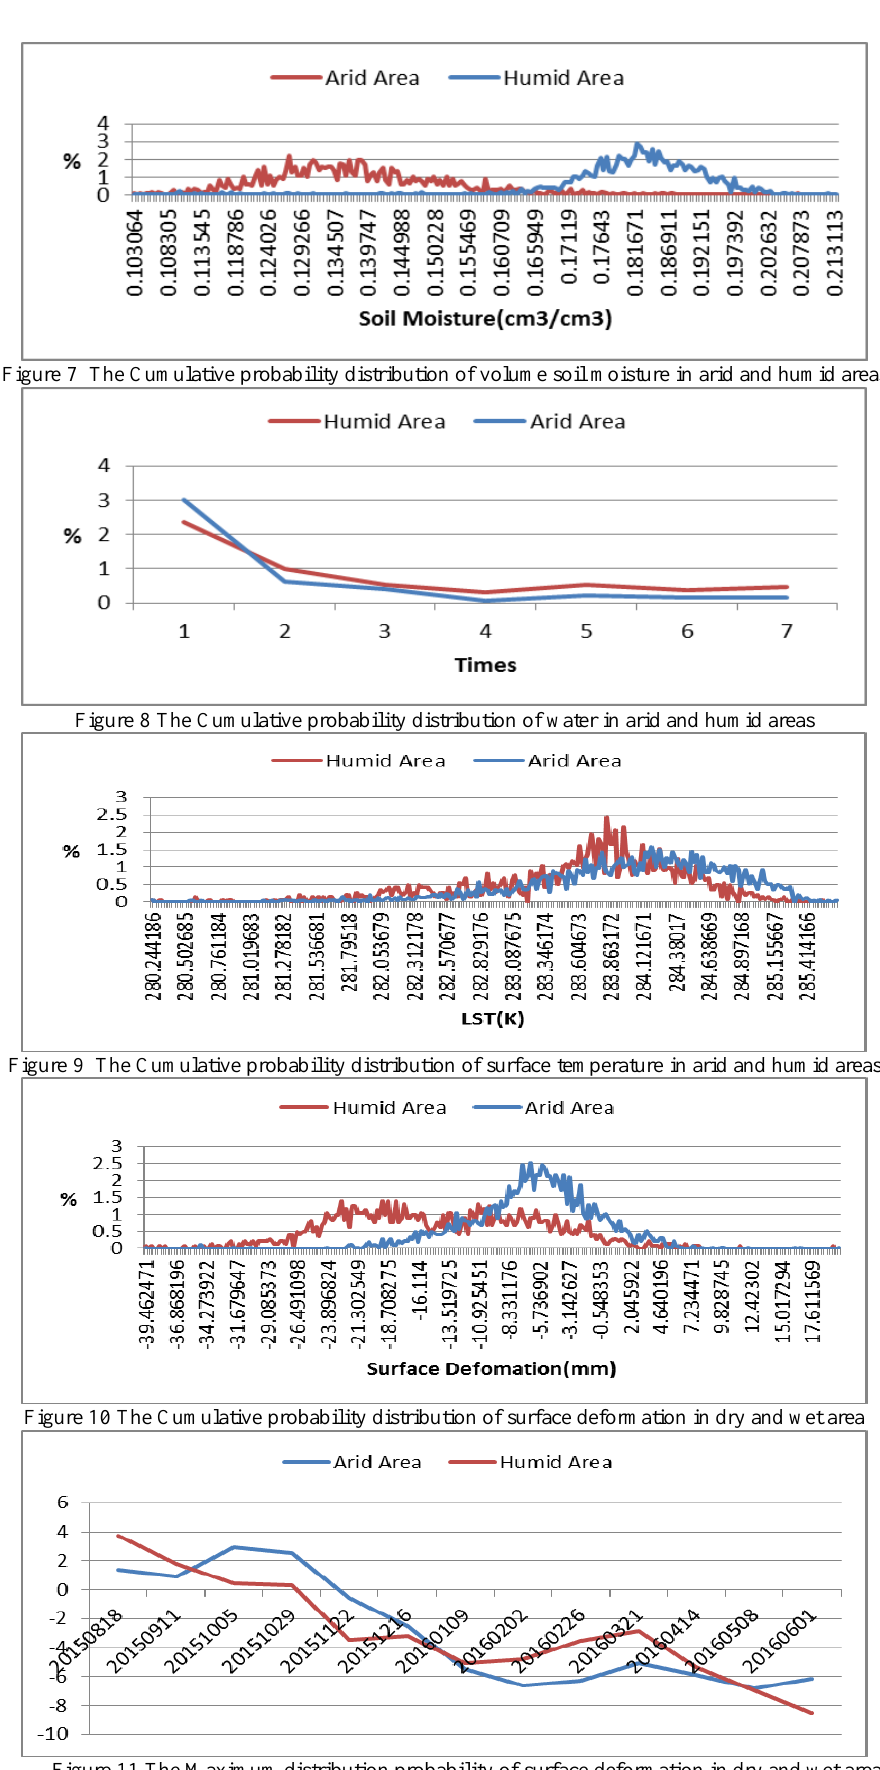
Figure 11 The Maximum distribution probability of surface deformation in dry and wet